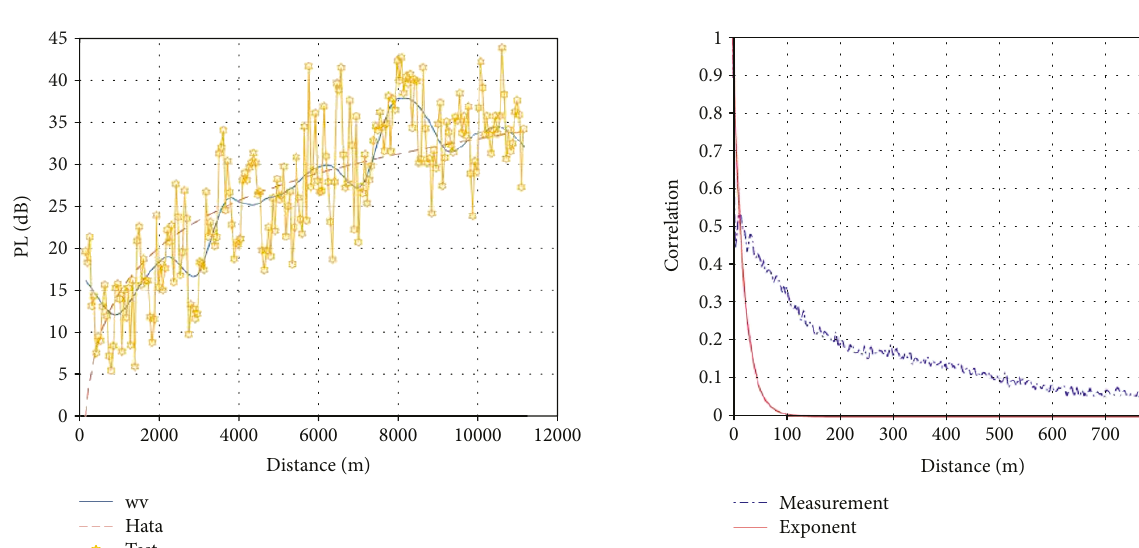
Figure 5: Slow fading correlation for measurement data. The fading correlation distance is 13.8meters for the measurement